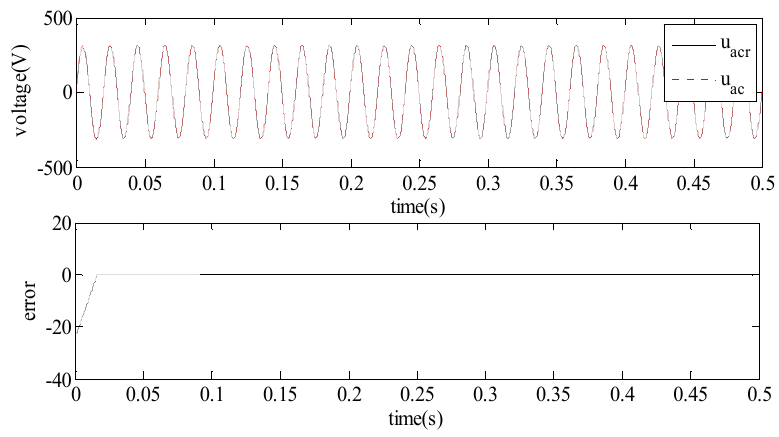
Figure 16. Tracking performance of the SMC scheme.